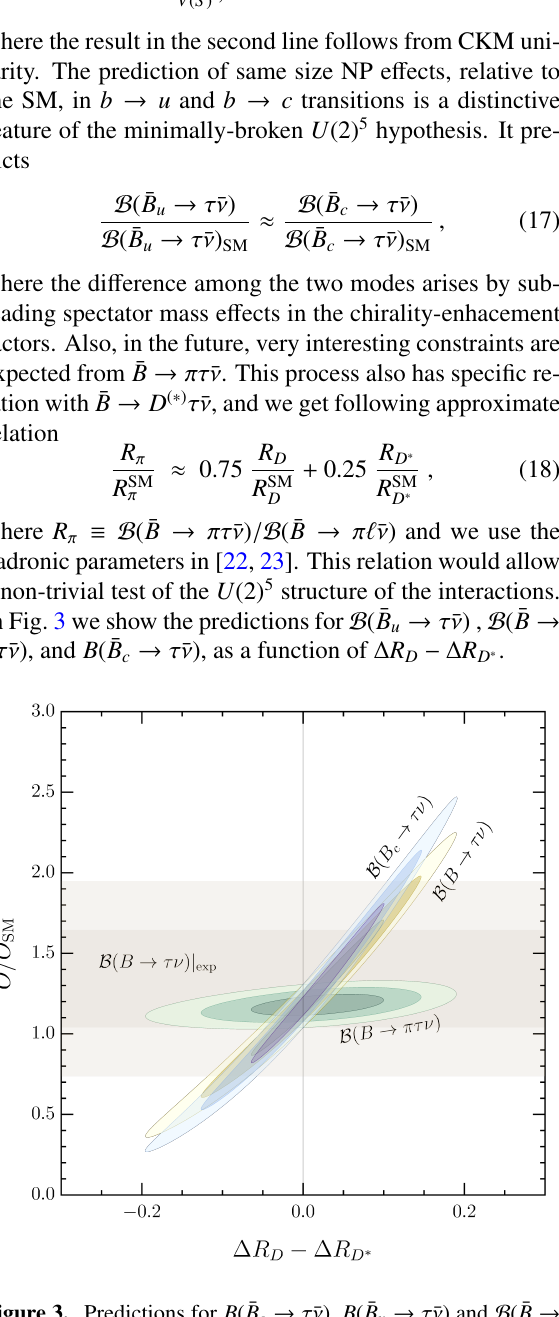
at 1 σ and 2 σ . L